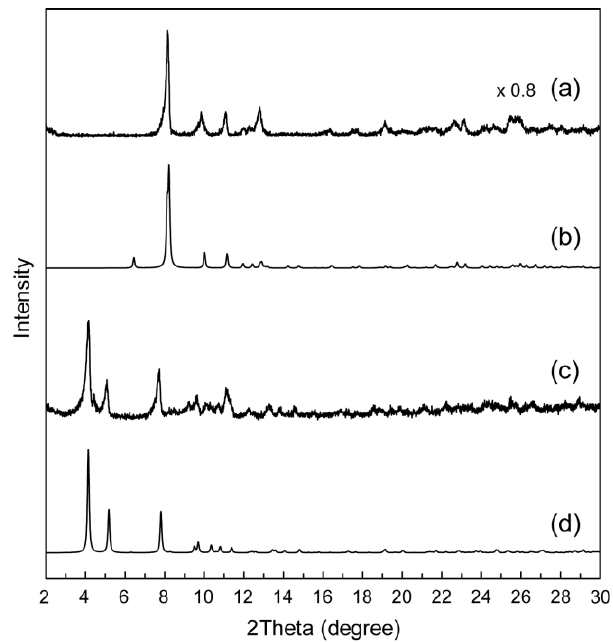
Figure 4. Powder XRD patterns of Mo 8 hybrid crystals: ( a ) as-prepared 1 ; ( b ) calculated pattern of 1 using the structure obtained by single-crystal X-ray diffraction; ( c ) as-prepared 2 ; ( d ) calculated pattern of 2 using the structure obtained by single-crystal X-ray diffraction.